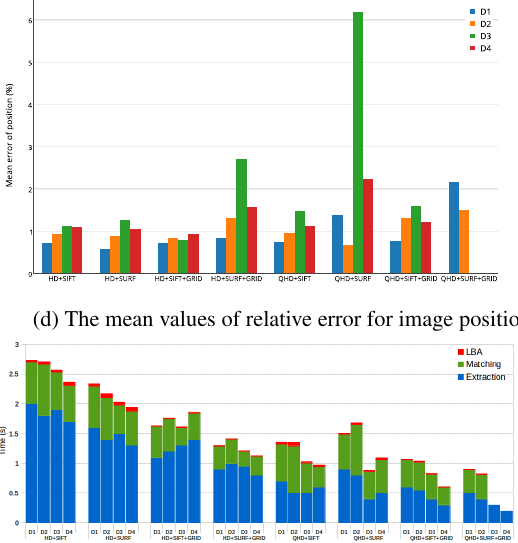
Figure 6. The experiment results for different